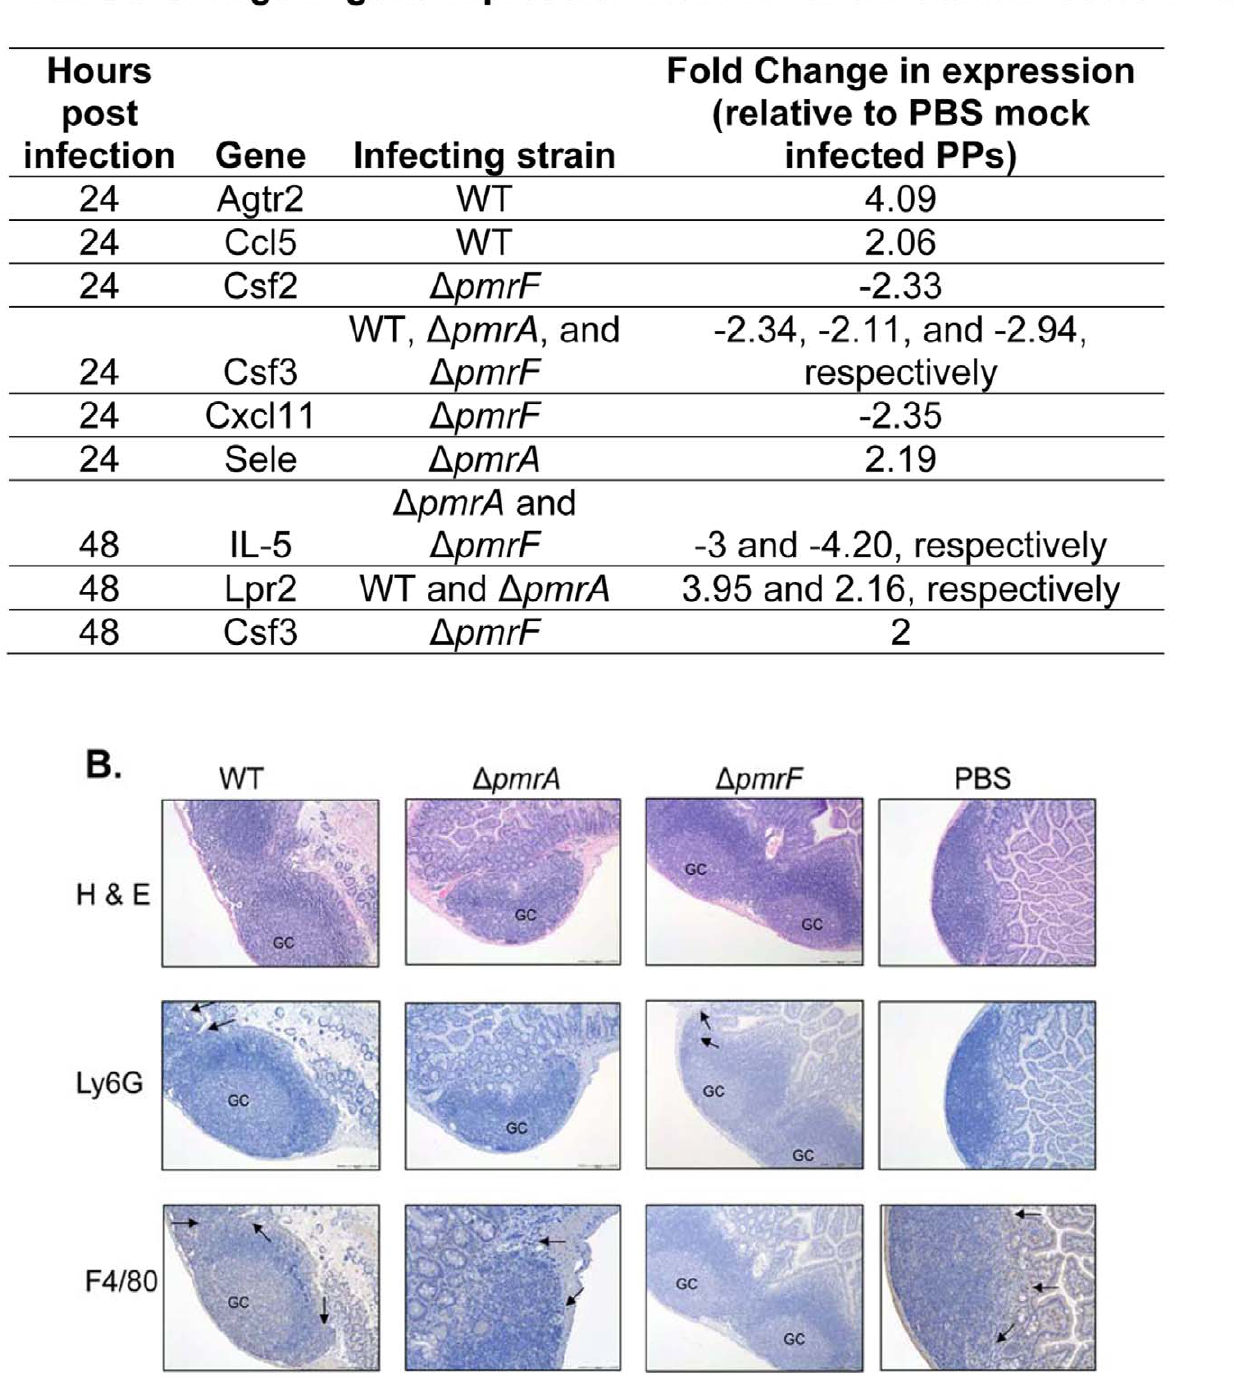
Figure 6. Immune response to oral infection with 10 8 CFU of WT, D pmrA, or D pmrFS. Typhimurium. (A.) Significant changes (2-fold or greater relative to uninfected controls) in immune-related gene expressionfrom mouse Peyer’s patches infected with WT, D pmrA, or D pmrF S. Typhimurium relative to PBS mock-infected Peyer’s patches. (B.) Hematoxylin and Eosin staining, and immunohistochemical stainging of Peyer’s patches infected with WT, pmrA, pmrF S. Typhimurium, or mock-infected with PBS for 48 hrs. Neutrophils were stained using Ly6G antibodies. Macrophages were stained using F4/80 antibodies. GC- germinal center.